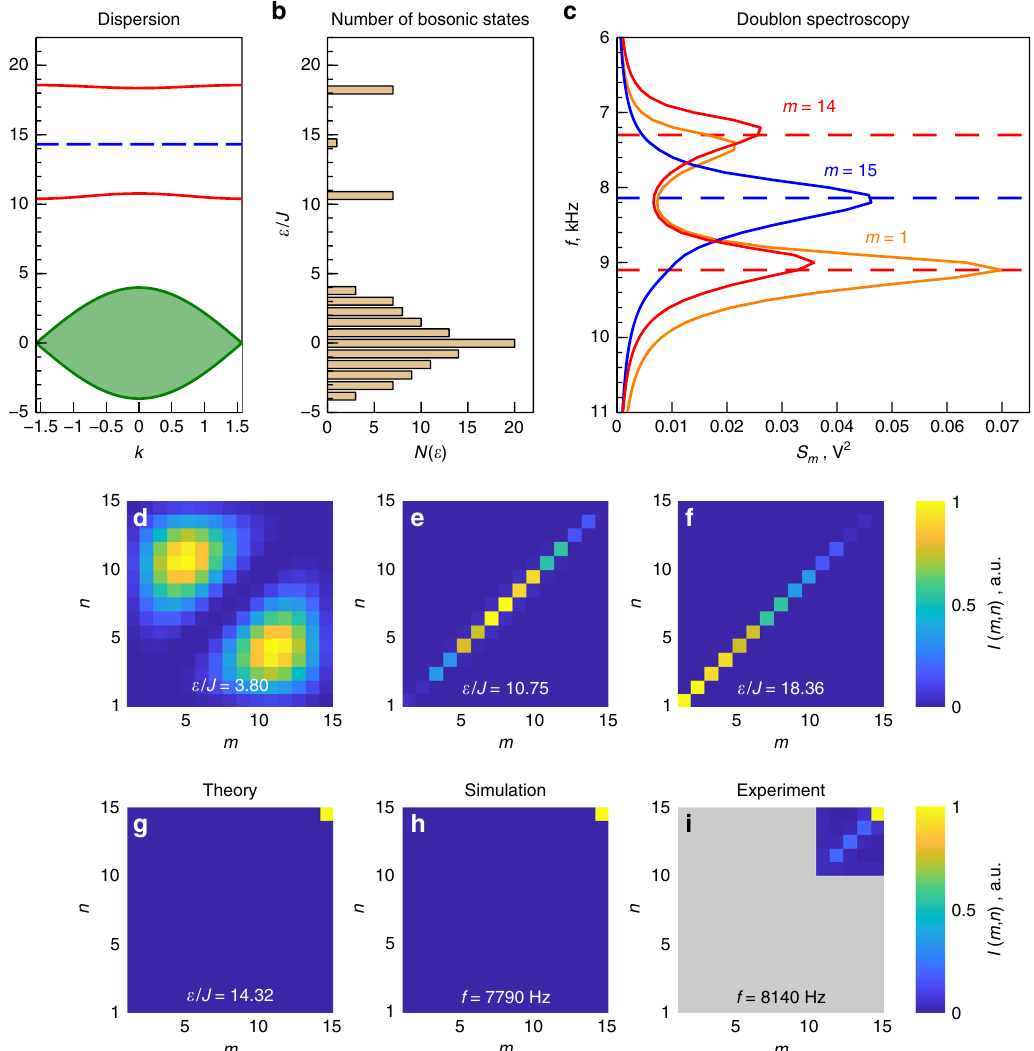
Fig. 2 Theoretical studies and experimental emulation of two-photon excitations. a Dispersion of two-photon eigenmodes calculated from the tight- binding model. Two red solid curves correspond to doublons, horizontal dashed line between them indicates the energy of the doublon edge state, and the shaded area at the bottom shows the continuum of two-photon scattering states. b Number of bosonic states in the tight-binding system of size 15×15 sites. c Doublon spectroscopy with quantity S m ( f ) [cf. Eq. (10)] determined from experimental data and plotted as a function of driving frequency. The feeding points (1, 1), (14, 14), and (15, 15) are labeled with corresponding values of m = 1, 14, 15 and are shown by orange, red, and blue solid lines, respectively. Characteristic peaks in the spectrum correspond to doublon modes. d – g Two-photon probability distributions ∣ β mn ∣ 2 for the eigenmodes of 15× 15 lattice described by the Hamiltonian Eq. (1) in the absence of disorder. Panels d, e, f and g correspond to the scattering states, lower and upper bulk doublon bands and doublon edge state, respectively. h Eigenmode reconstruction for a circuit of 15×15 nodes simulated taking into account the disorder in the element values as well as Ohmic losses (see “ Methods ” section for details). i Experimental implementation of the eigenmode reconstruction for the doublon edge